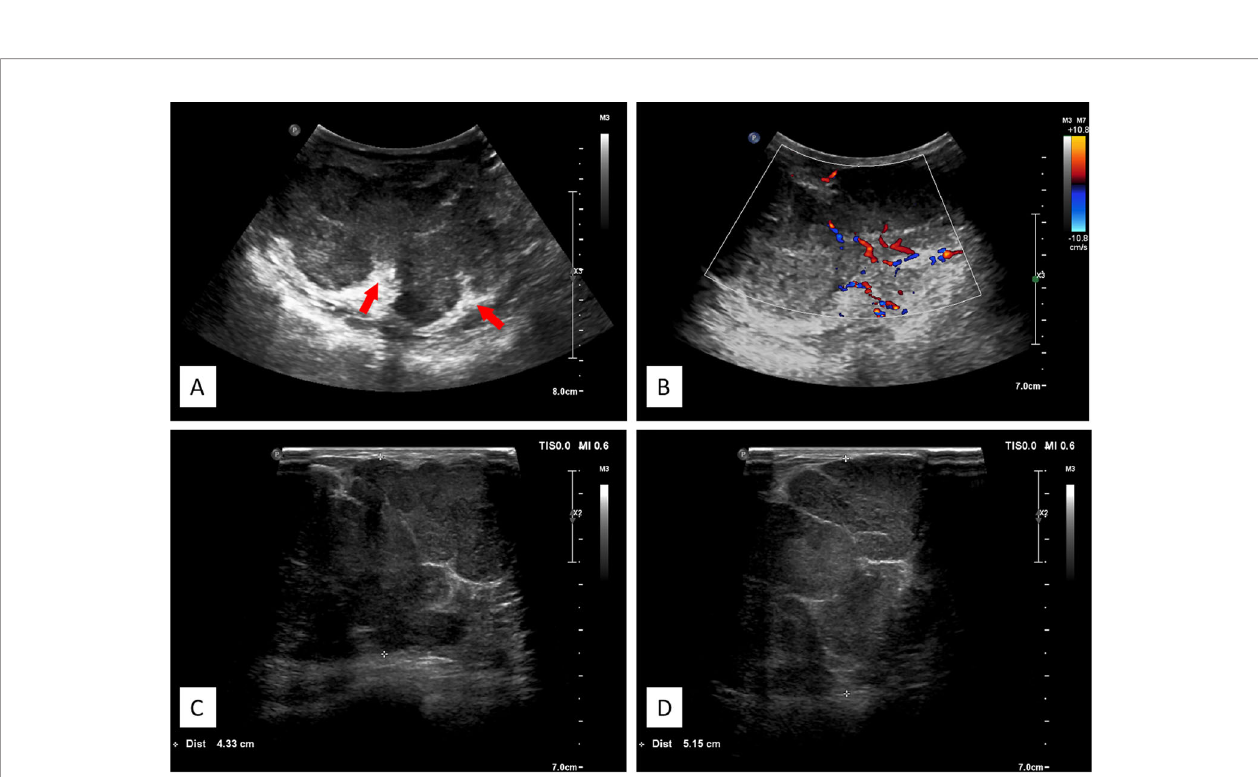
FIGURE 2 | (A) Ultrasonographic image showing multiple hypoechoic lesions in the right breast. The large masses comprising nearly the entire right breast, with lobulated irregular margin, the banded median-high echogenic septum was seen inside the mass. (B) Color fl ow Doppler image showing abundant blood fl ow signals. (C, D) Different spliced images of the tumor showed irregular margin with multiple